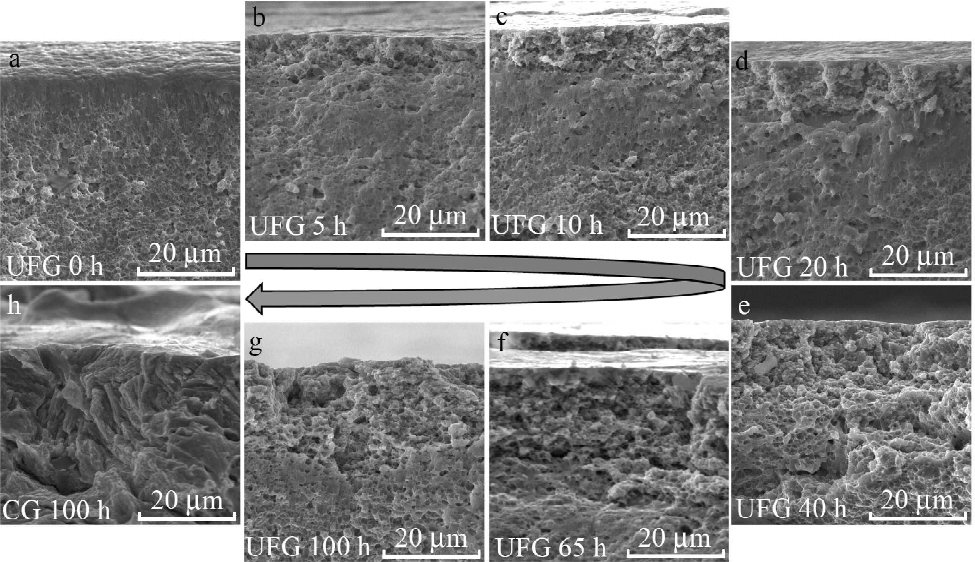
Fig. 13. The characteristic SEM micrographs of the fracture surfaces in UFG-CrNiTi steel in dependence on hydrogen-charging duration (a–g) and in CG-CrNiTi steel after 100h-hydrogen-charging (h). One side of the fracture surface is presented for each specimen on images (a)-(h).